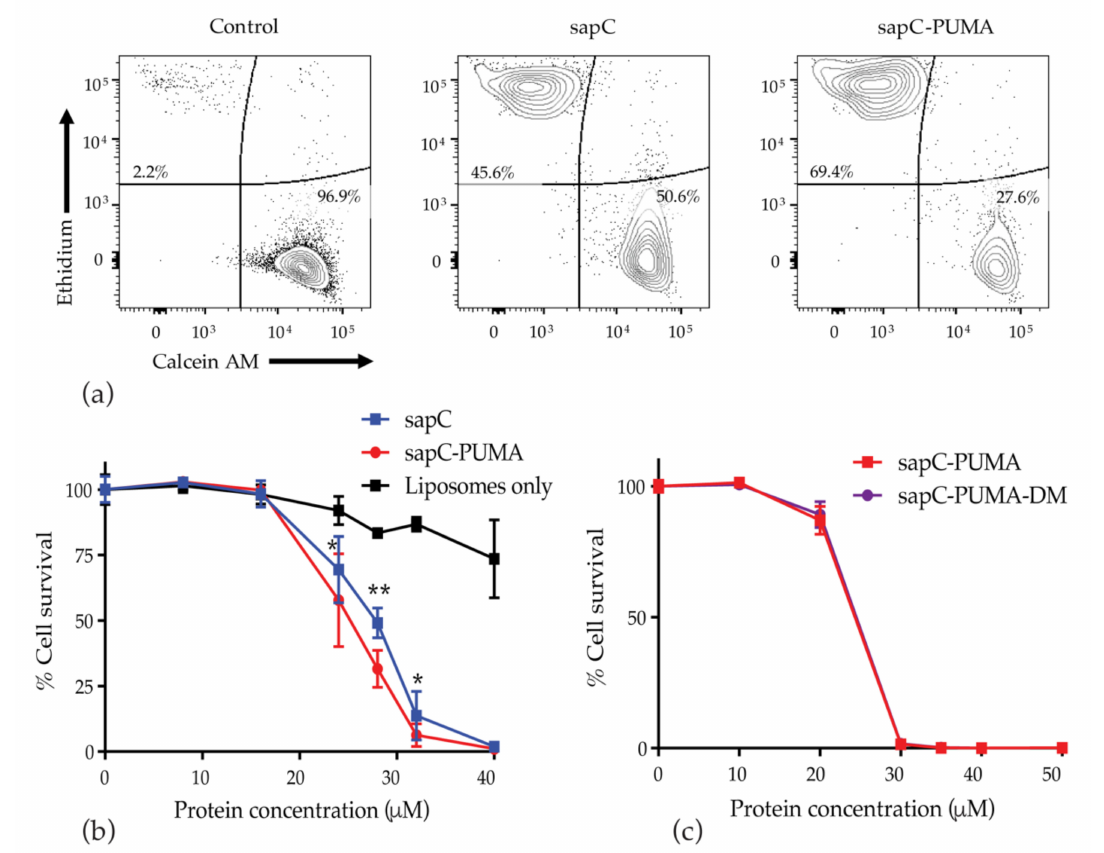
Figure 10. SapC-PUMA proteoliposomes enhance cellular toxicity relative to sapC: U-87 MG cells were cultured for 72 h in the presence of proteoliposomes composed of PS and different concentrations of sapC, sapC-PUMA, and sapC-PUMA-DM, or with liposomes alone (concentrations determined as described in the Materials and Methods section). Cell viability was analyzed by flow cytometry. Calcein AM+Ethidium— live cells from each treatment group were determined and cell survival was calculated relative to PBS control. ( a ) Representative flow cytometry plots of 28 µ M protein treatment or PBS control. ( b ) Combined data from all protein concentrations. ( c ) sapC-PUMA and sapC-PUMA-DM proteoliposomes were compared for their effect on cell viability at the indicated concentrations. Data in panels ( b , c ) are from different experiments under the same experimental conditions except for slight variations in protein concentration. Data are from at least five replicates per group. Statistical analysis to compare sapC and sapC-PUMA was performed by Student’s t -test with * p < 0.05; ** p < 0.01. Table 1. Killing activity of sapC-PUMA and sapC-PUMA-DM proteoliposomes: killing activity is defined as the ratio of percentages of cells killed by the indicated protein treatments from assays as described in Figure 10. A ratio of 1 indicates equal killing between the specified proteins at a given concentration. Underlined values denote enhanced killing activity with a p -value < 0.05 by Student’s t -test. Data are from at least five replicates per group. U87-MG Human Astrocytes SapC-PUMA/SapC SapC-PUMA-DM/SapC-PUMA Conc. ( µ